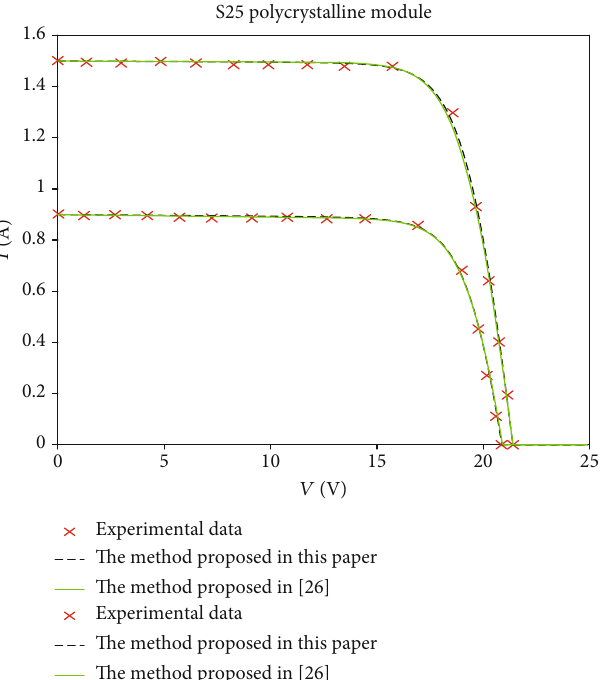
Figure 7: I – V characteristics under varying temperature for SP75 monocrystalline module ( G = 1000 W/m 2 ).